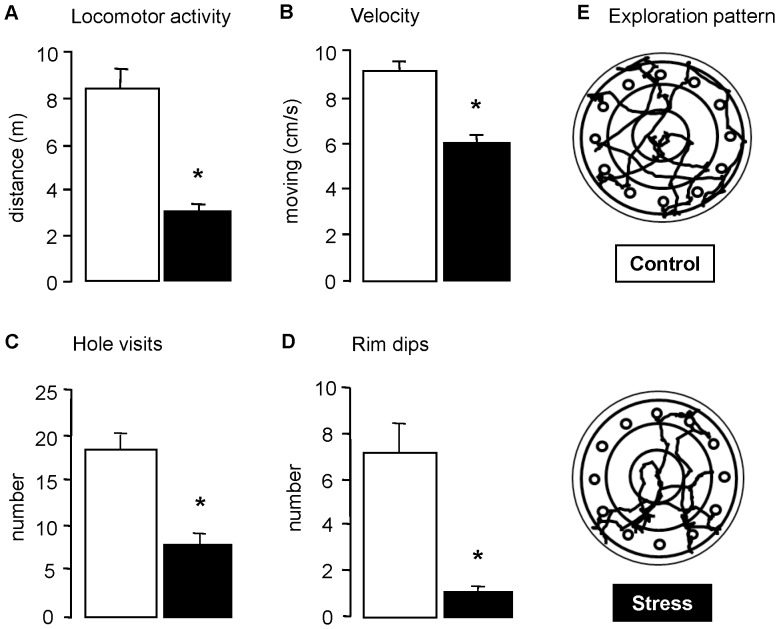
The experimental design of the study.Over the course of 9–10 weeks, male C57BL/6J mice were subjected to several procedures. The grey box highlights the time of the chronic stress procedure. Abbreviations: CHB  =  circular hole board; FET  =  free exploration trial.